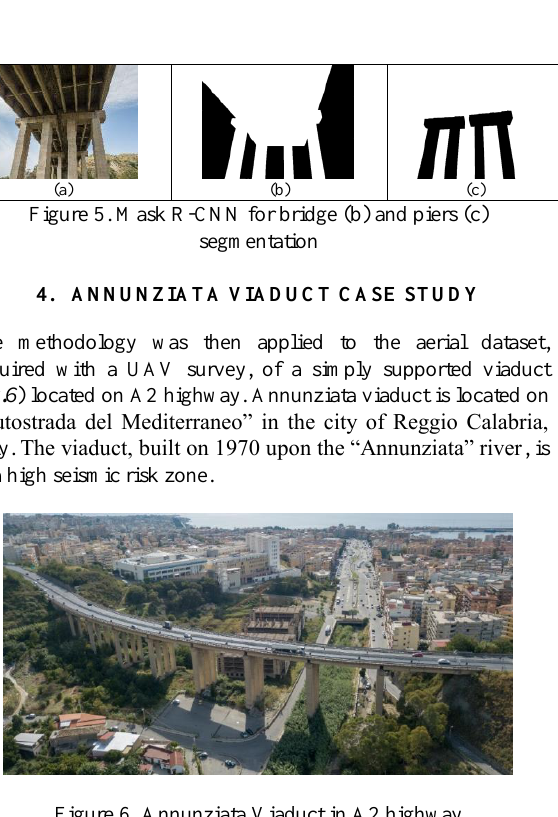
Figure 6. Annunziata Viaduct in A2 highway